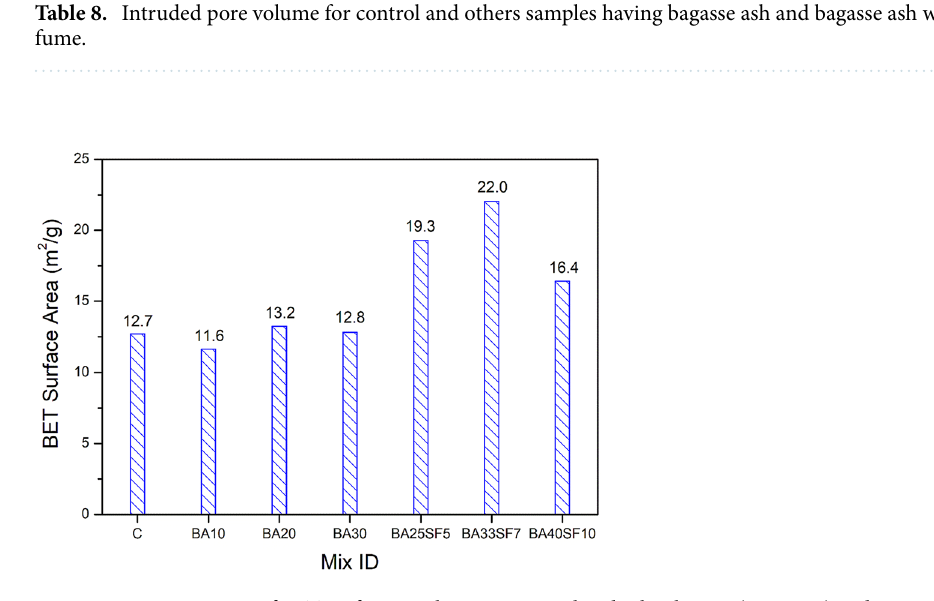
Figure 13. Comparison of BET surface area between control and other binary (OPC-BA) and ternary (OPC- BA-SF) concrete